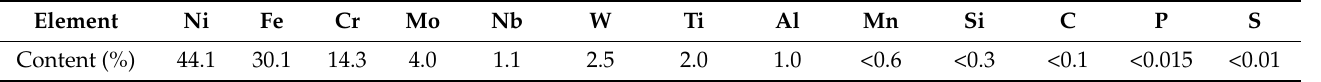
Table 1. Chemical composition of the XH45MBTJuBP alloy.